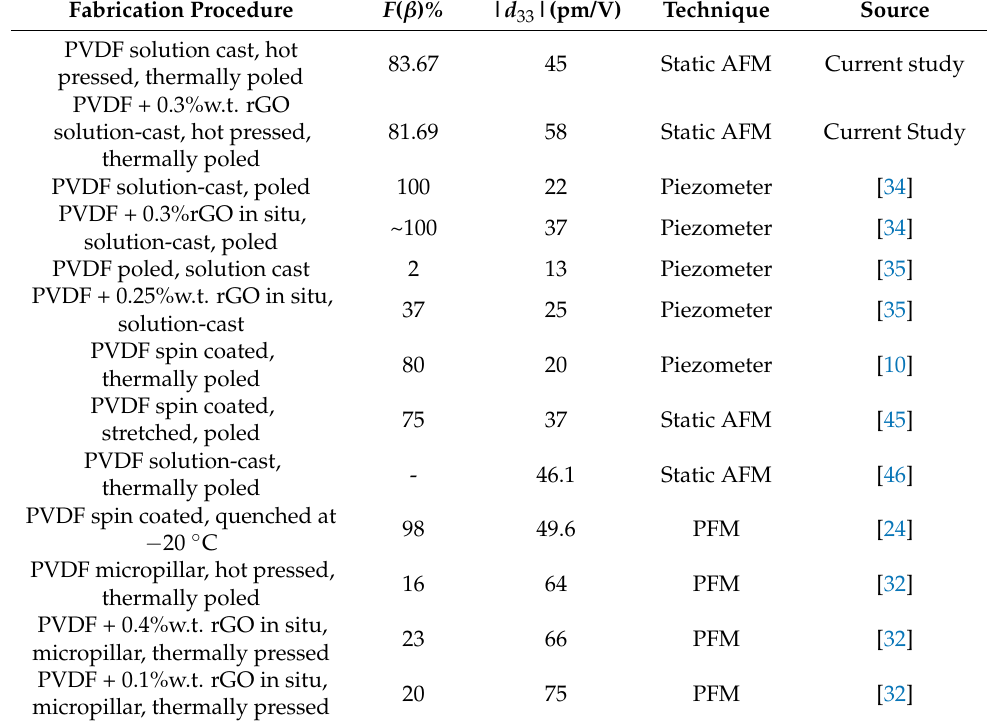
Table 3. Comparative literature review of PVDF piezoelectric coefficient